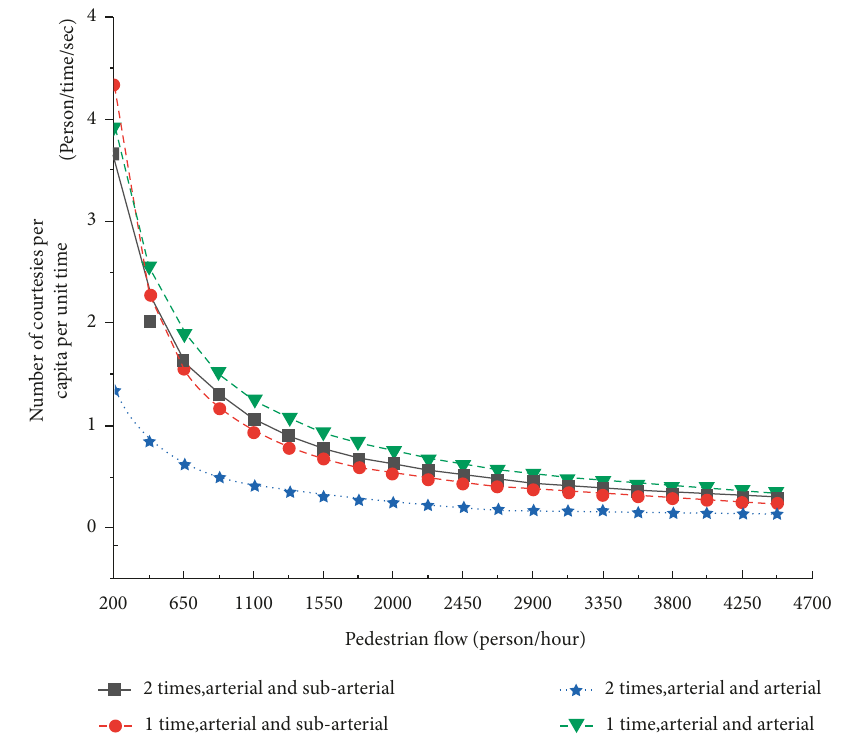
Figure 13: Variation trend of average yield number per people at an